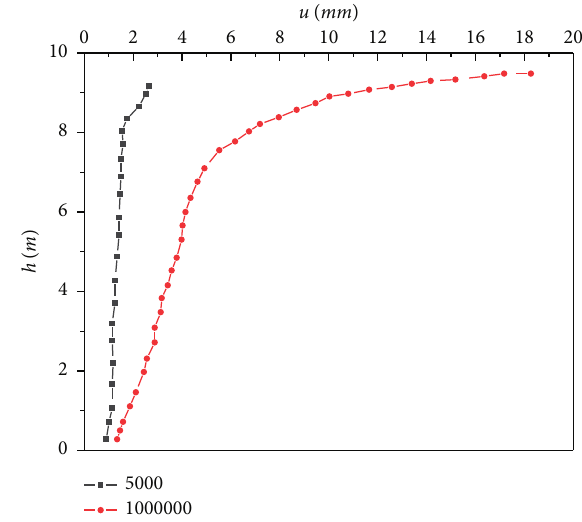
Figure 22: Permanent deformation of the subgrade changes along the depth